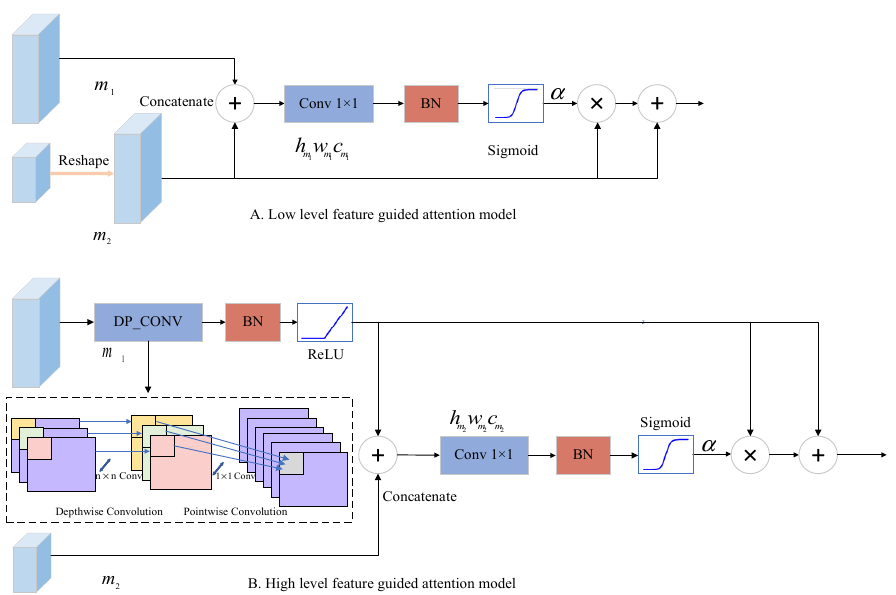
Figure 3. The structure of SSA. The low-level feature guided attention module and the high-level feature guided module are illustrated in ( A ) and ( B ).